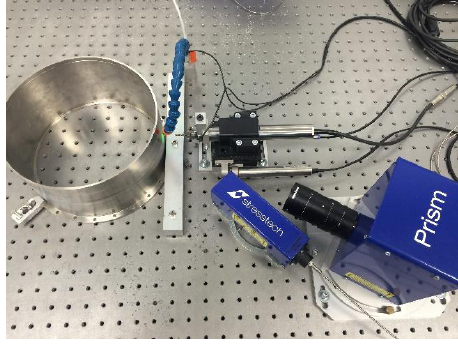
Figure 11. Residual stress measurement